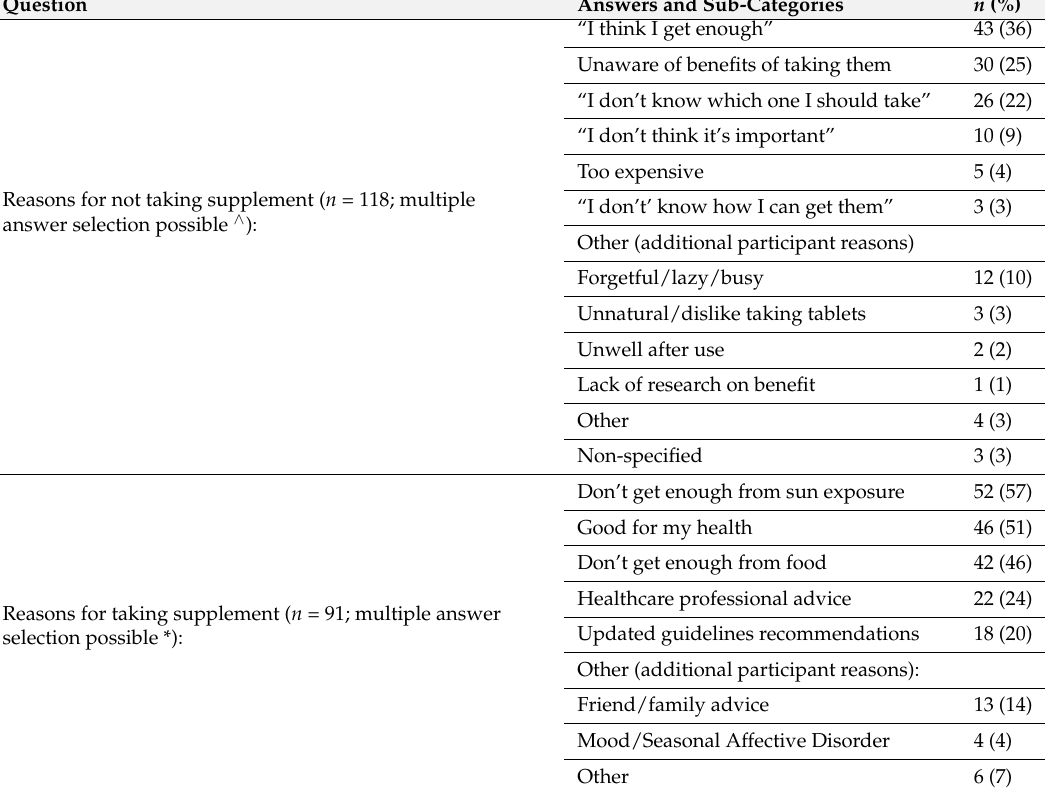
Table 4. UK participants’ perceptions of vitamin D supplementation ( n = 209).